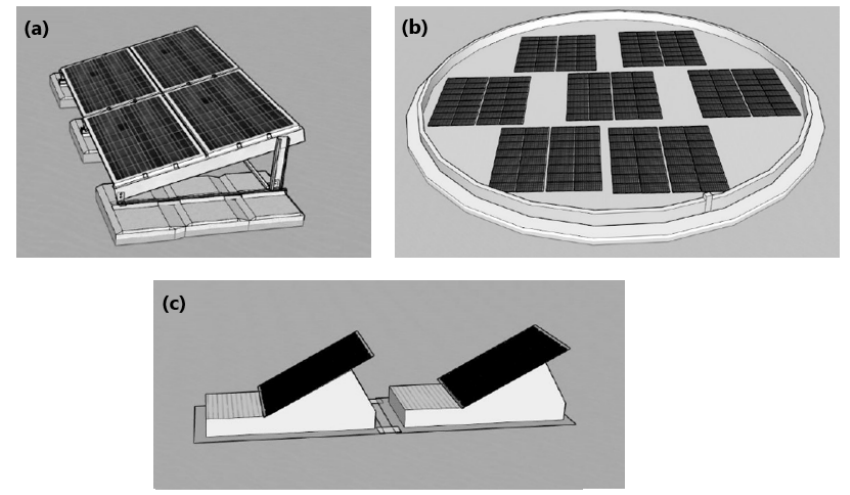
Figure 2. Classification of FPV structures: ( a ) Modular raft, ( b ) Membranes, ( c ) Pure float. Adapted from